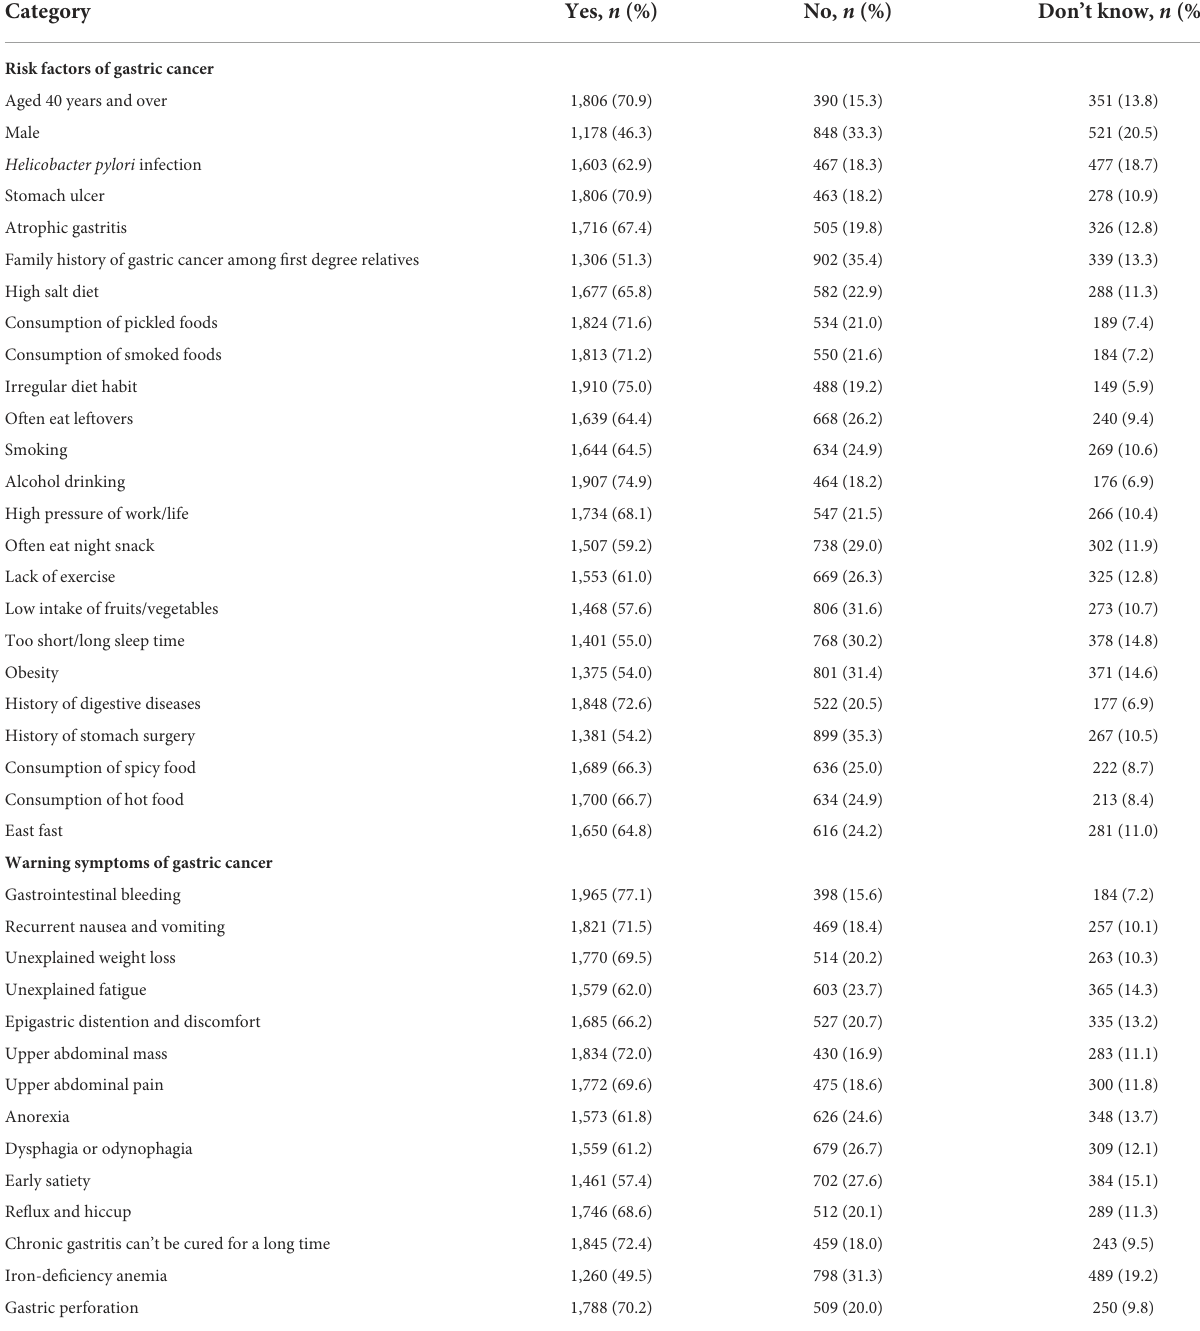
TABLE 2 Respondents’ knowledge about risk factors and warning symptoms of gastric